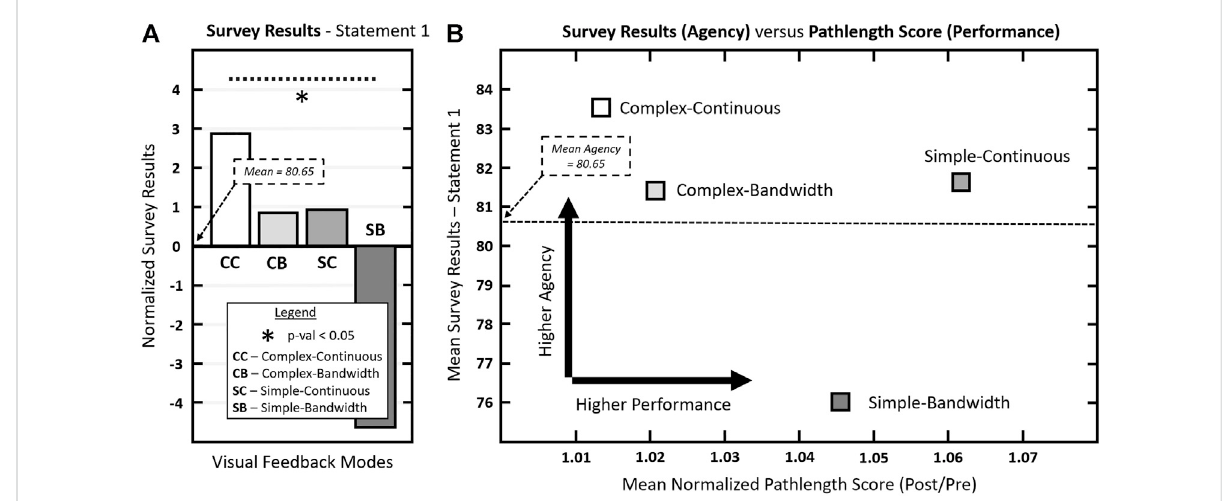
FIGURE 9 Survey results. (A) Survey score results for agency for each visual feedback mode. (B) Agency results versus relative change (pre to post) in pathlength score